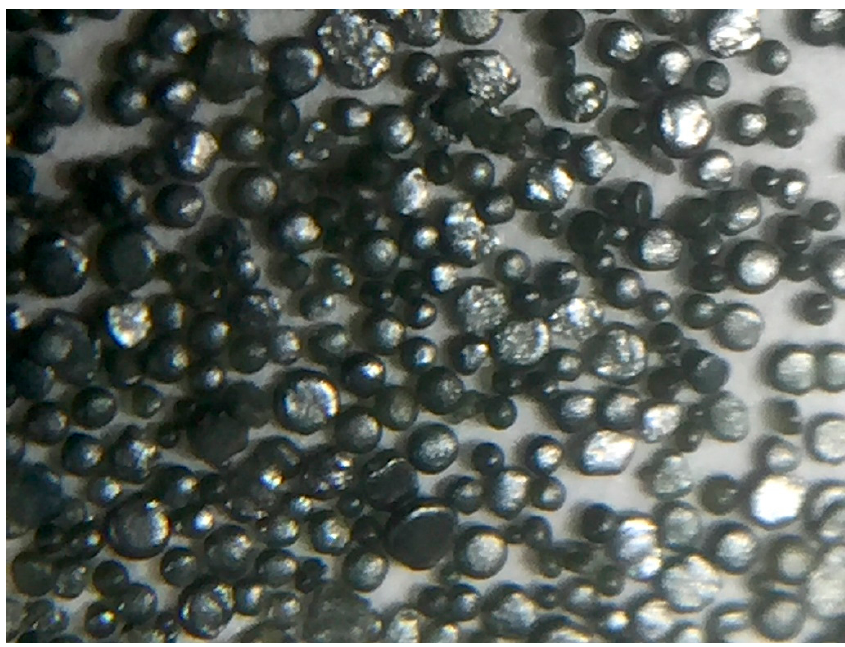
Figure 2. Propellant from a 0.22 ″ blank cartridge (10×).